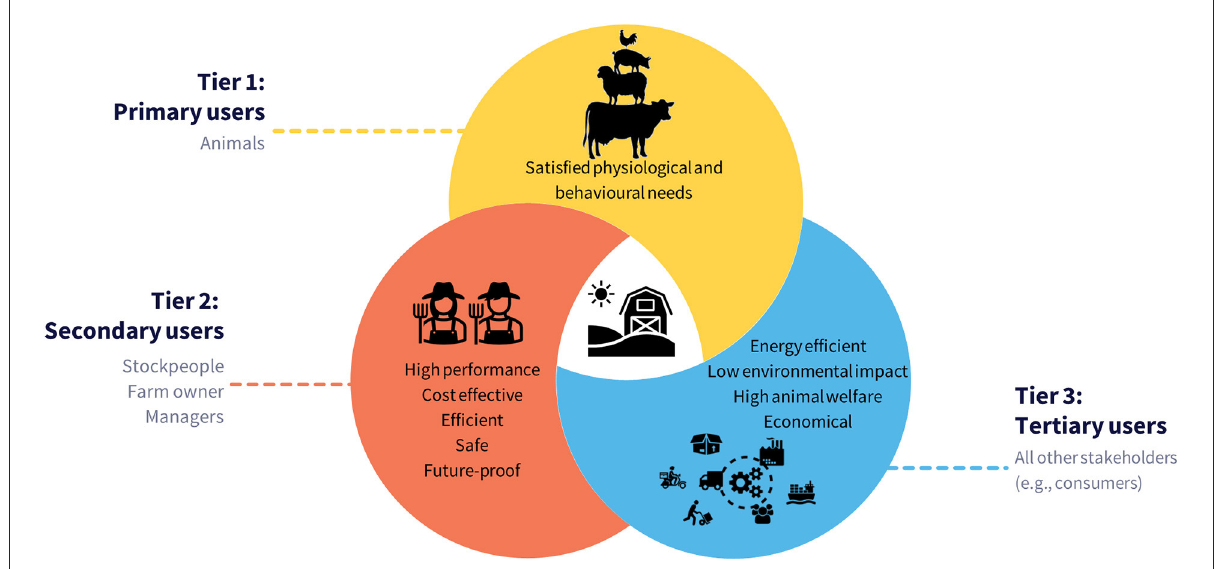
FIGURE1 Diagram representing the “triangle of needs” between all users of a farming system. Tier 1 involves the animals who are the primary users occupying the system 100% of the time. Tier 2 are secondary users who are on the farm daily (e.g., stockpeople). Tier 3 are tertiary users and includes all other stakeholders who have an opinion about the system (e.g., consumers, retailers, and civil society) but may never interact directly with the system.